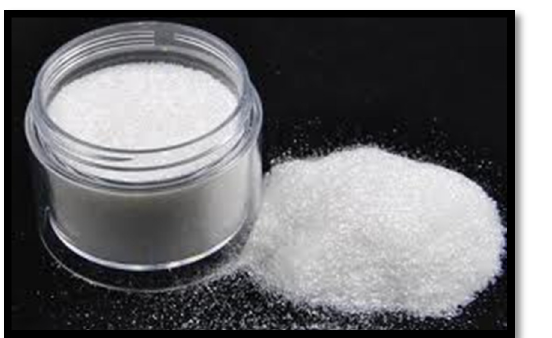
Fig. 4: Glass powder used in brick samples